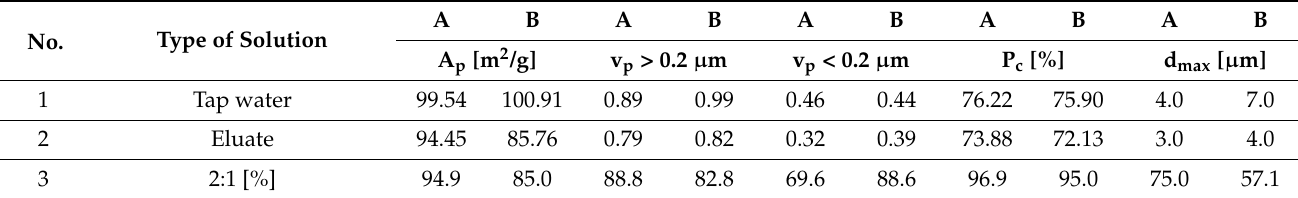
Table 5. List of parameters characterizing the microstructure of tested hardening